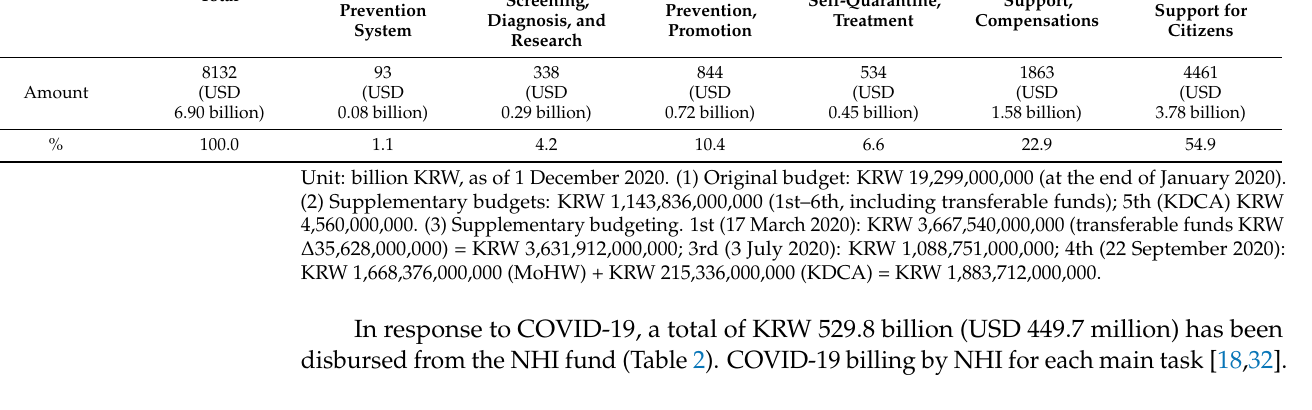
Table 2. COVID-19 billing from the National Health Insurance for each main task